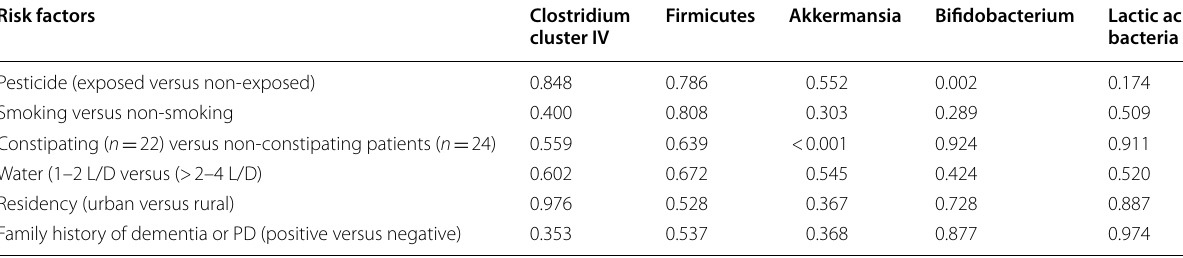
Table 4 Correlation between gut microbiota and risk factors of Parkinson’s